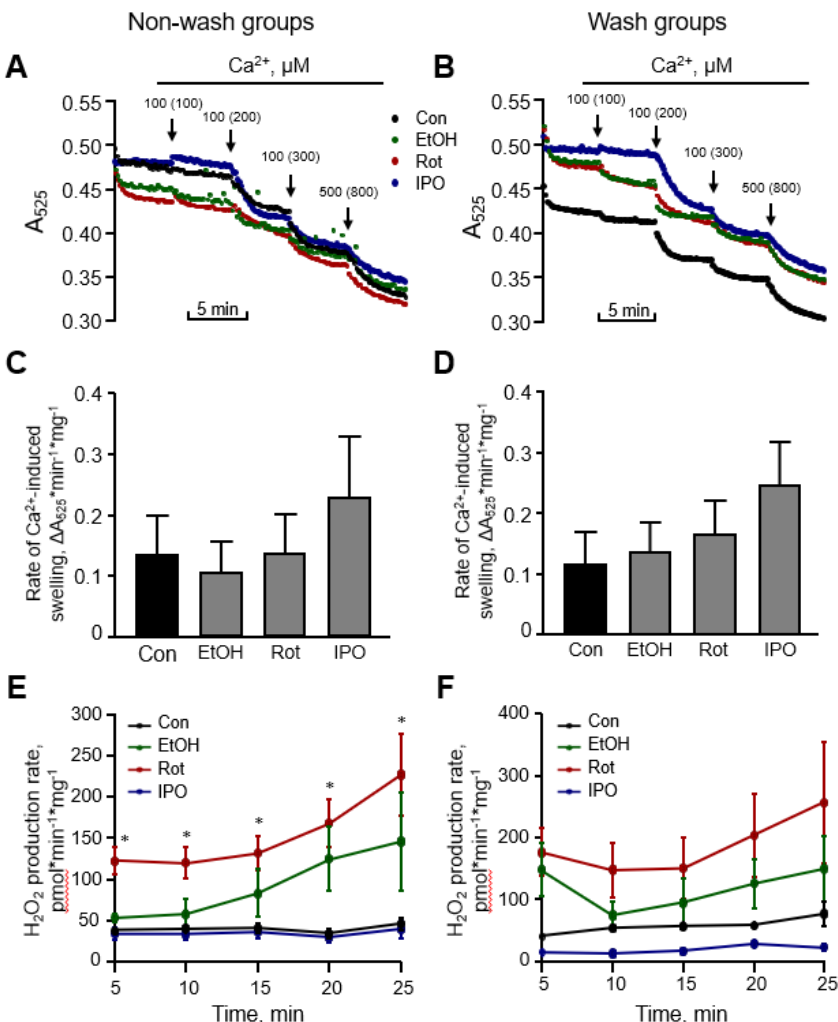
Figure 3. Mitochondrial swelling and reactive oxygen species (ROS) production rates. Representative curves ( A , B ) and quantitative data ( C , D ) of mitochondrial swelling, and the rates of mitochondrial ROS production rates ( E , F ). Mitochondrial swelling as a marker of permeability transition pore (PTP) opening was induced by addition of CaCl 2 , shown as the added and the final (cumulative) concentration in brackets, and measured by monitoring the decrease in light scattering at 525 nm. Quantitative data ( C , D ) are given for mitochondrial swelling rates induced by 200 µ M Ca 2 + . Basal (no Ca 2 + ) rates of mitochondrial ROS production ( E , F ) were measured for 25 min with 5-min intervals. Con, control; EtOH, ethanol; Iso, isopropanol; Rot, rotenone. * p < 0.05 Con vs. Rot, n = 6–8 per each group.